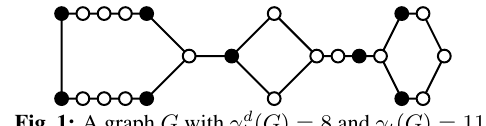
Fig. 1: A graph G with γ d t ( G ) = 8 and γ t ( G ) = 11 .